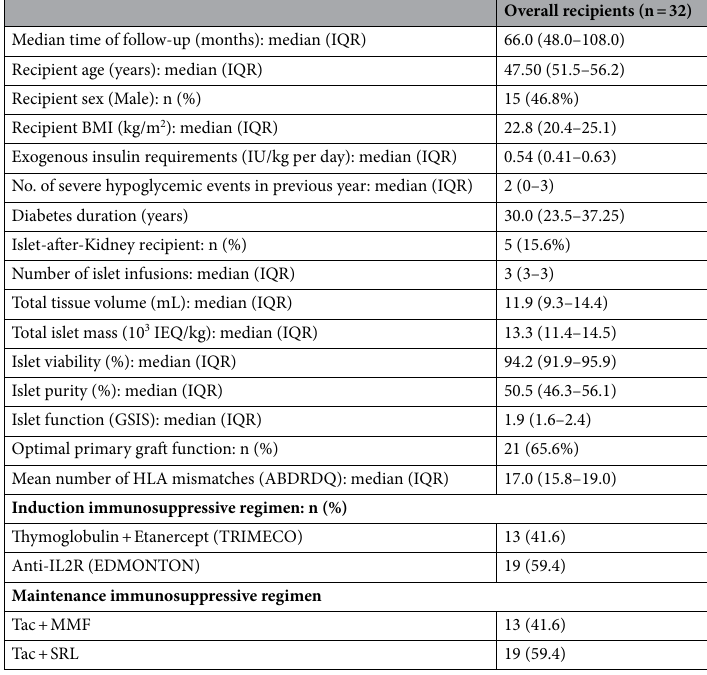
Table 1. Baseline characteristics of the cohort. BMI Body-Mass index, GSIS Static Glucose-stimulated Insulin Secretion, HLA Human Leukocyte Antigen, IL2R: Interleukin 2–Receptor; IU insulin unit, MMF